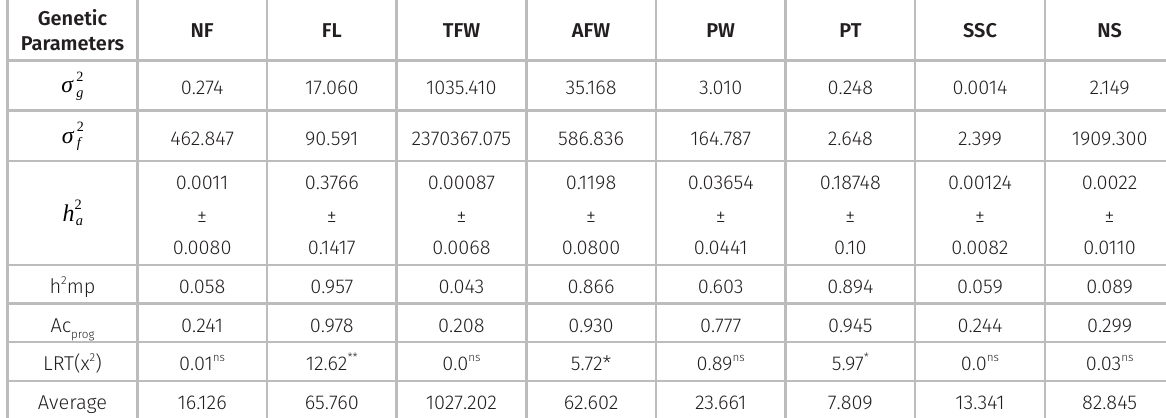
Table II. Estimates of genetic parameters in passion fruit segregating populations by REML procedure for characteristics number of fruits per plant (NF), fruit length (FL), total fruit weight (TFW), average fruit weight (AFW), pulp weight (PW), peel thickness (PT), soluble solids content (SSC) and number of seeds (NS). Genetic